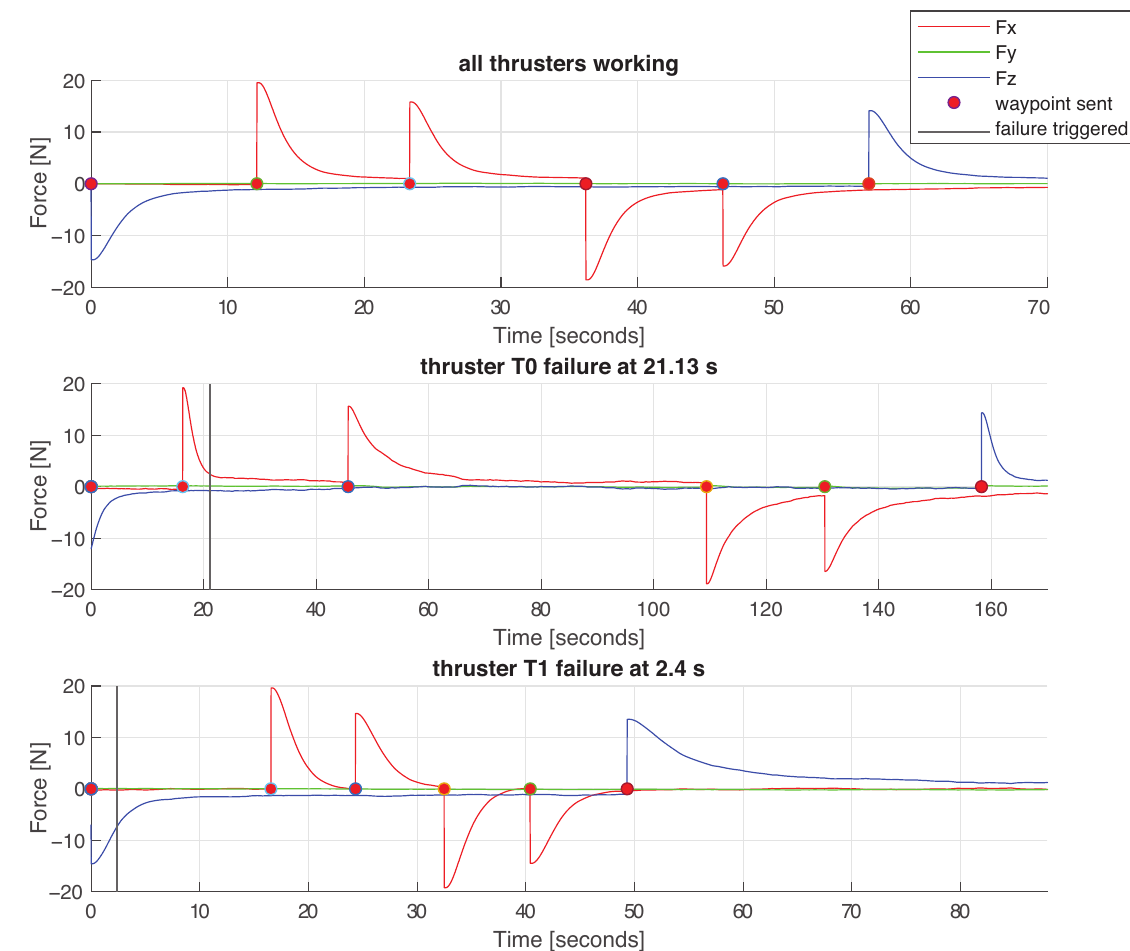
Figure 10. Force reference commands obtained by the FL controller. Uppermost figure represent the I test, middle the II and bottom the III . The time instance when each waypoint is sent is depicted with a red circle, and the moment of the thruster failure is depicted with a vertical black line.